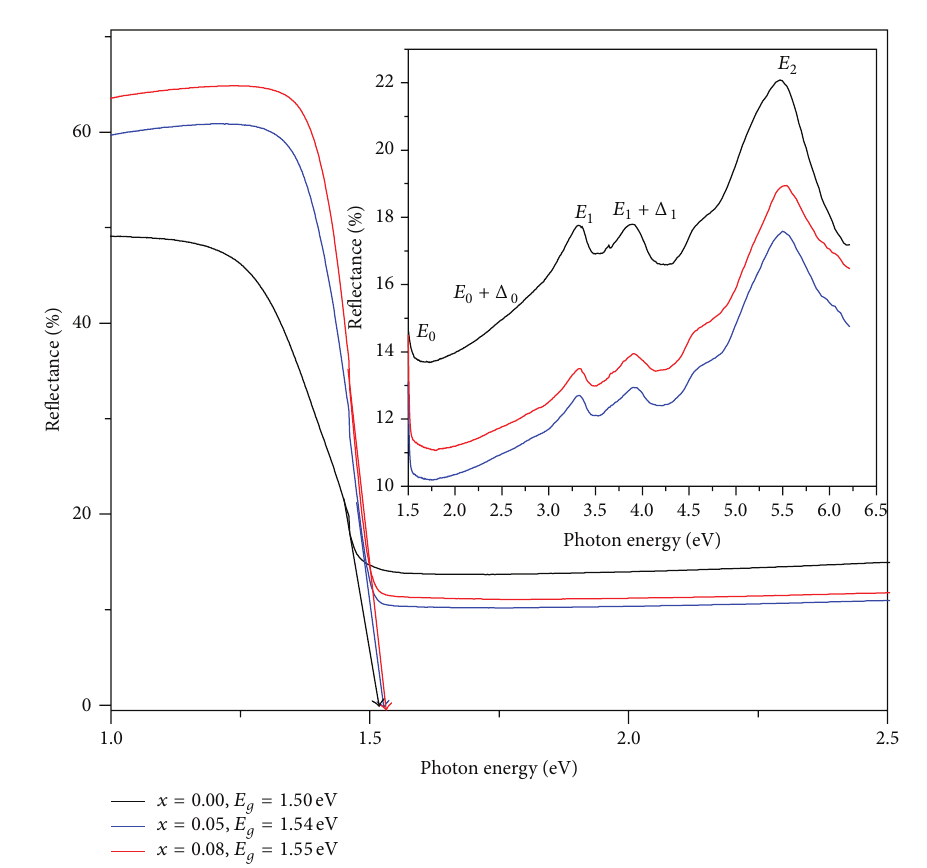
Figure 4: Plot of reflectance versus photon energy (eV) for pure and Co doped CdTe alloy